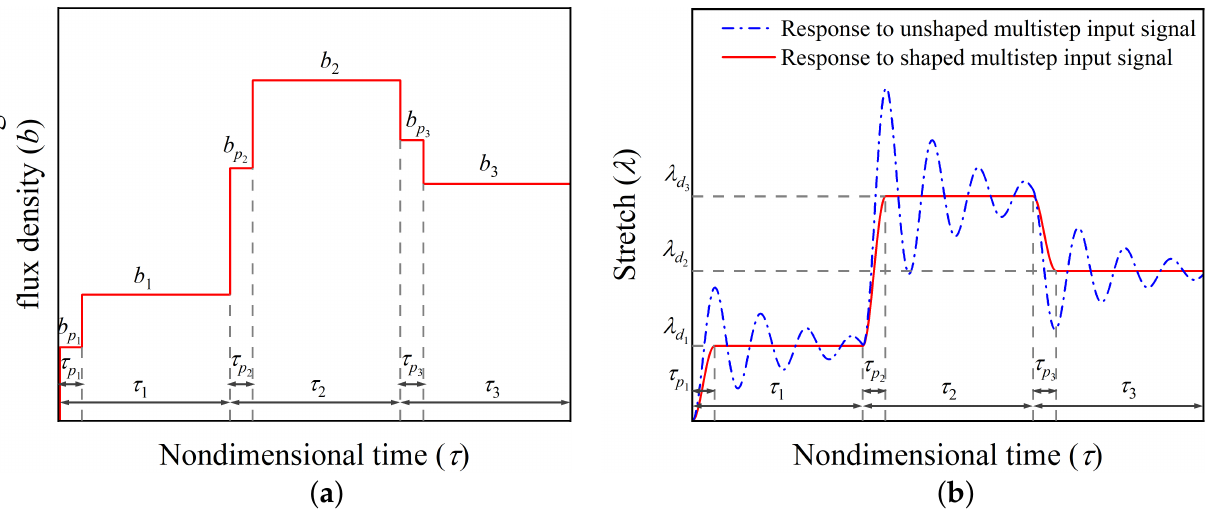
Figure 4. ( a ) Shaped multi-step magnetic flux density input signal for achieving three desired equilibrium positions, and ( b ) the transient response of the hard-magnetic soft actuator subjected to shaped and unshaped multi-step input